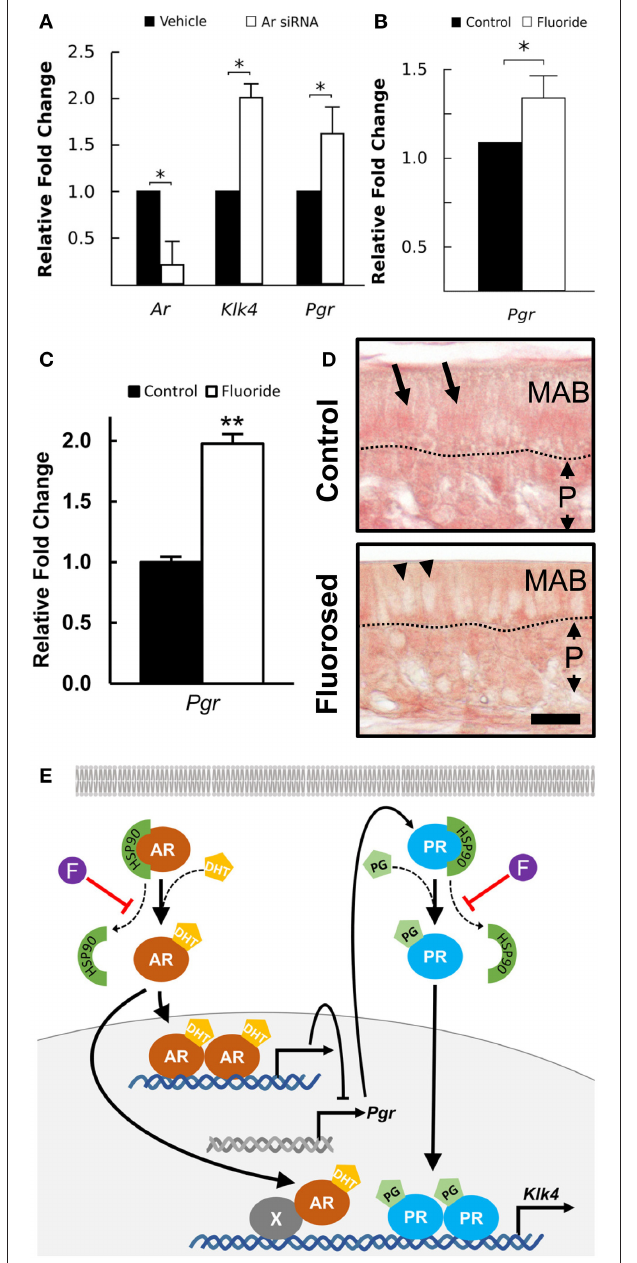
FIGURE 6 | Aluminum is required for fluoride to inhibit AR translocation into nucleus. Immunofluorescent analysis of AR in ALCs cultured in medium containing 2% TCM ® serum replacement. (A) By adding DHT, increased AR staining (in red) in the nucleus is observed compared with non DHT treated cells (control). (B) When cells are treated with DHT, subsequent exposure to 1mM fluoride does not change the intracellular localization of AR as compared to the control. However, when cells are exposed to 100 µ M aluminum, together with fluoride, more AR remains in the cytoplasm. The increased cytoplasmic AR co-localizes with HSP90 (in green), and is seen as the overlaid yellow color. DAPI in blue, Scale bar 25 µ m. drinking water (Suzuki et al., 2014). We also confirmed that Klk4 expression is reduced in maturation stage enamel organs of rats and mice exposed to high levels of fluoride in drinking water,